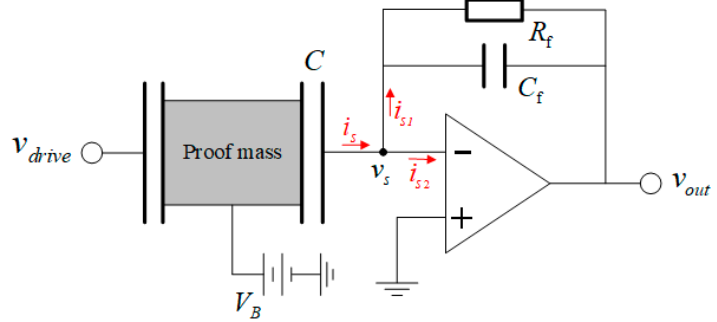
Figure 7. Electrical circuit model.